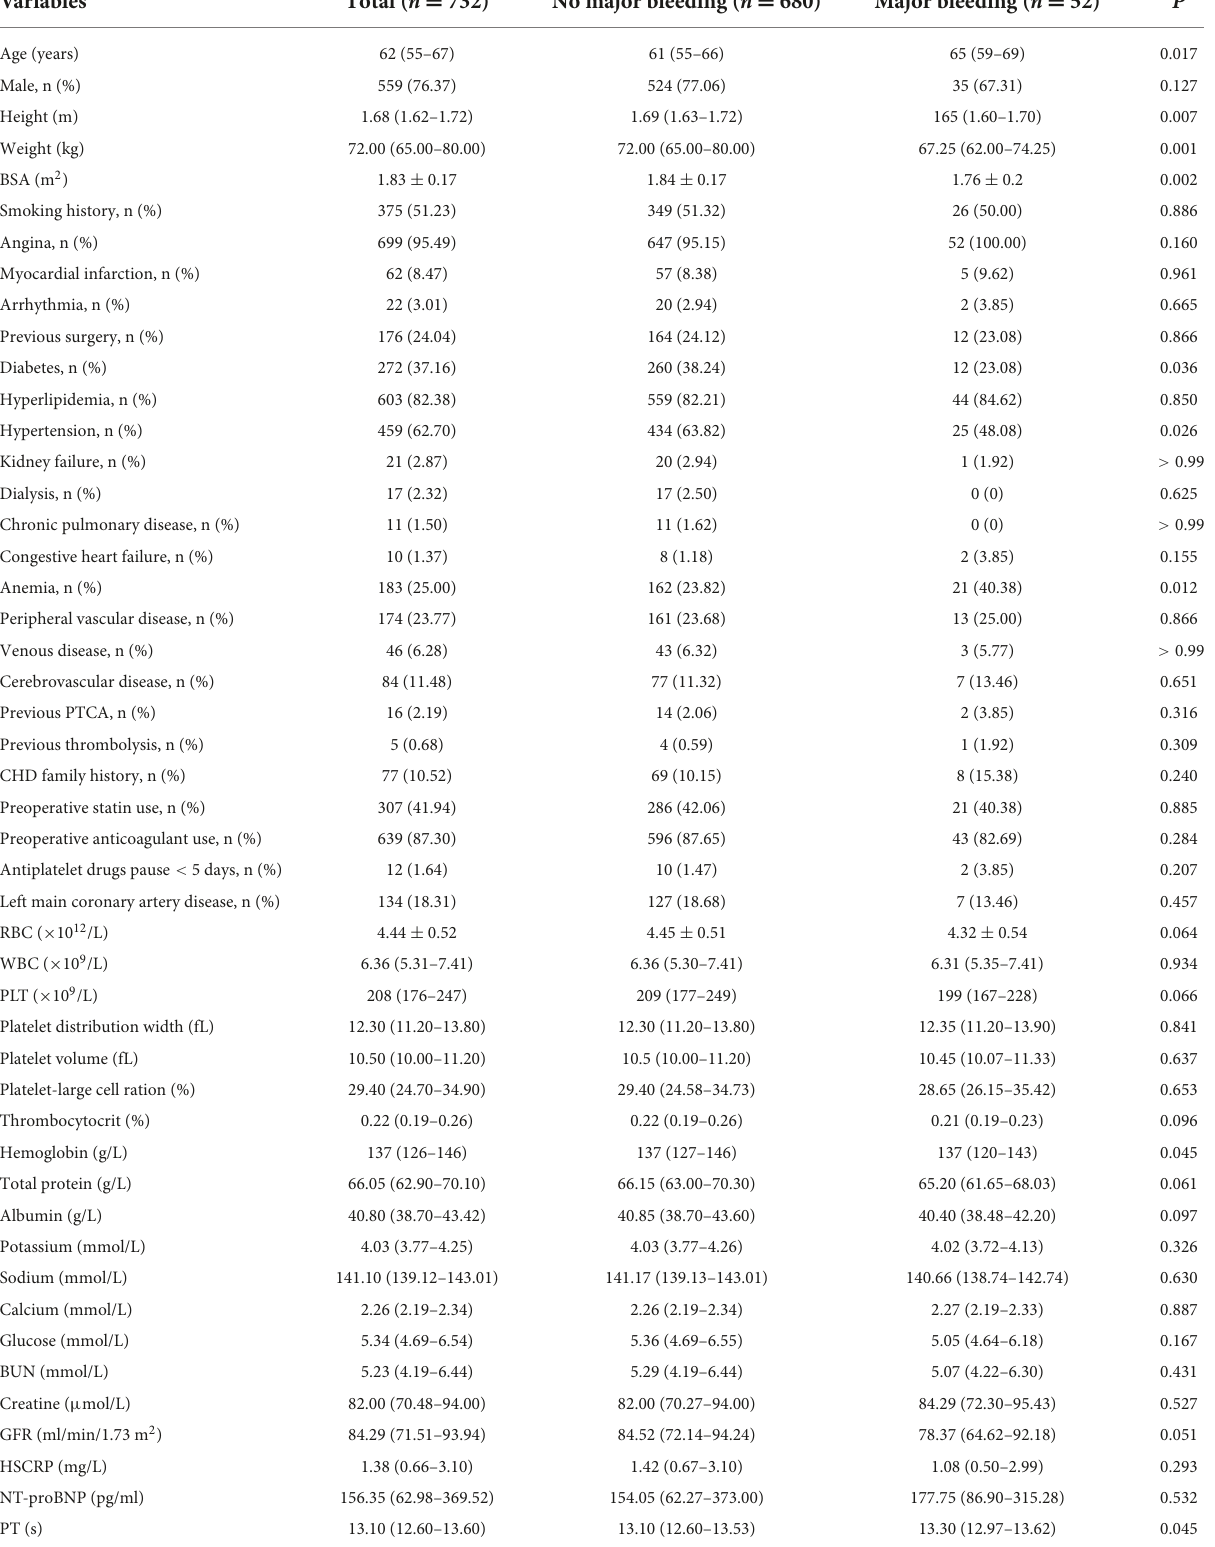
TABLE 1 Baseline characteristics of the training